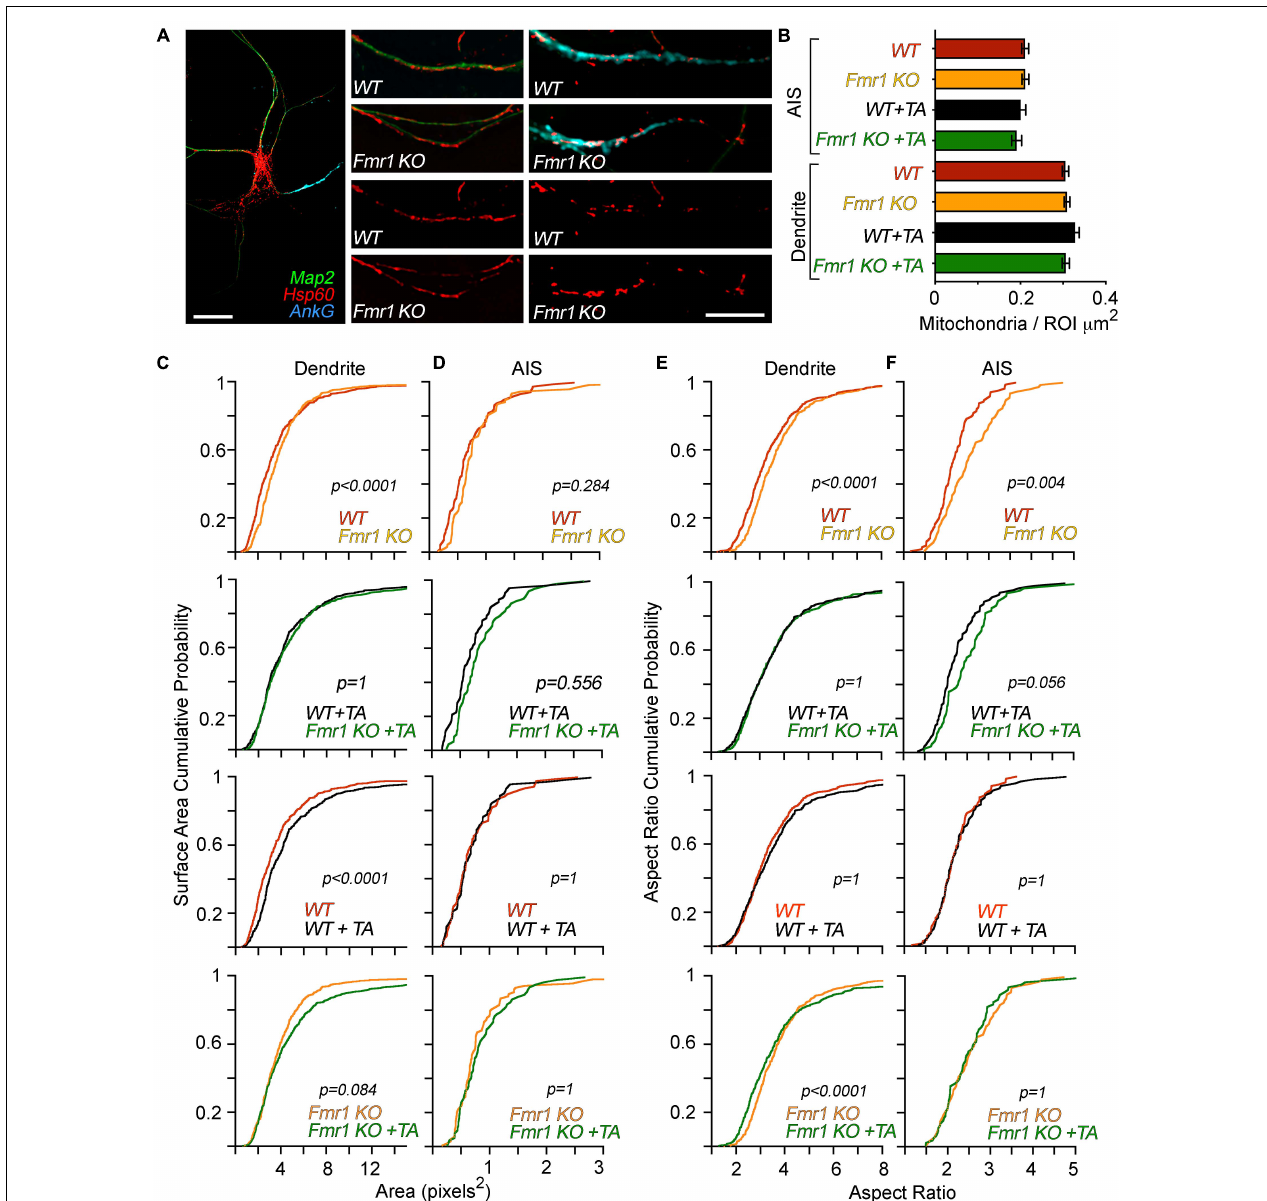
FIGURE 1 | Genotype-specific, compartment-specific, and treatment-specific alterations in mitochondrial morphology. Layout: the top row is composed of representative images and quantification of the number of mitochondria in dendrites and AIS, respectively. Underneath, four rows comprise data on mitochondrial morphology. Each vertical row has the following presentation of data comparisons: WT control vs. Fmr1 -KO control, WT + TTX/APV vs. Fmr1 -KO + TTX/APV, WT control vs. WT + TTX/APV, and Fmr1 -KO control vs. Fmr1 -KO + TTX/APV. (A) Representative images of immunofluorescence co-labeling of Hsp60, Map2, and Ank G. Scale bars = 20 µ m. From left: full neuron, dendrite, AIS. (B) Quantification of mitochondrial content in dendrites and AIS. There were no differences in content of mitochondria between any conditions. Error bars represent the standard error of the mean. (C) Quantification and comparison of dendritic mitochondrial surface area before and after TTX/APV treatment. At baseline, mitochondria display a significantly larger surface area in Fmr1 KO compared to WT. TTX/APV increases mitochondrial surface area in WT dendrites. Fmr1 -KO mitochondria display a non-significant trend toward an increase of surface area following TTX/APV. (D) Quantification and comparison of AIS mitochondrial surface area before and after TTX/APV treatment. There are no differences in surface area between any conditions before or after TTX/APV. (E) Quantification and comparison of dendritic mitochondrial aspect ratio between genotypes before and after TTX/APV treatment. At baseline, the mitochondrial aspect ratio is increased in Fmr1 -KO neurons, but this difference is abolished after TTX/APV. Interestingly, Fmr1 -KO mitochondria display a small but significant increase in the aspect ratio after TTX/APV, while no changes occur in the WT. (F) Quantification and comparison of AIS-residing mitochondrial aspect ratio before and after TTX/APV treatment. At baseline, mitochondria display increased aspect ratio in Fmr1 -KO AIS compared to WT, but this difference is lost after TTX/APV treatment. All figures represent data from N = 3 biological replicates from independent littermate culture sets. Each analyzed dendrite and AIS represents an individual data point. N of analyzed dendrites: WT n = 400, Fmr1 KO n = 427, WT + TA n = 366, Fmr1 -KO + TA n = 377. N of AIS: WT n = 90, Fmr1 -KO n = 80, WT + TA n = 74, Fmr1 -KO + TA n = 69. TA = TTX/APV.